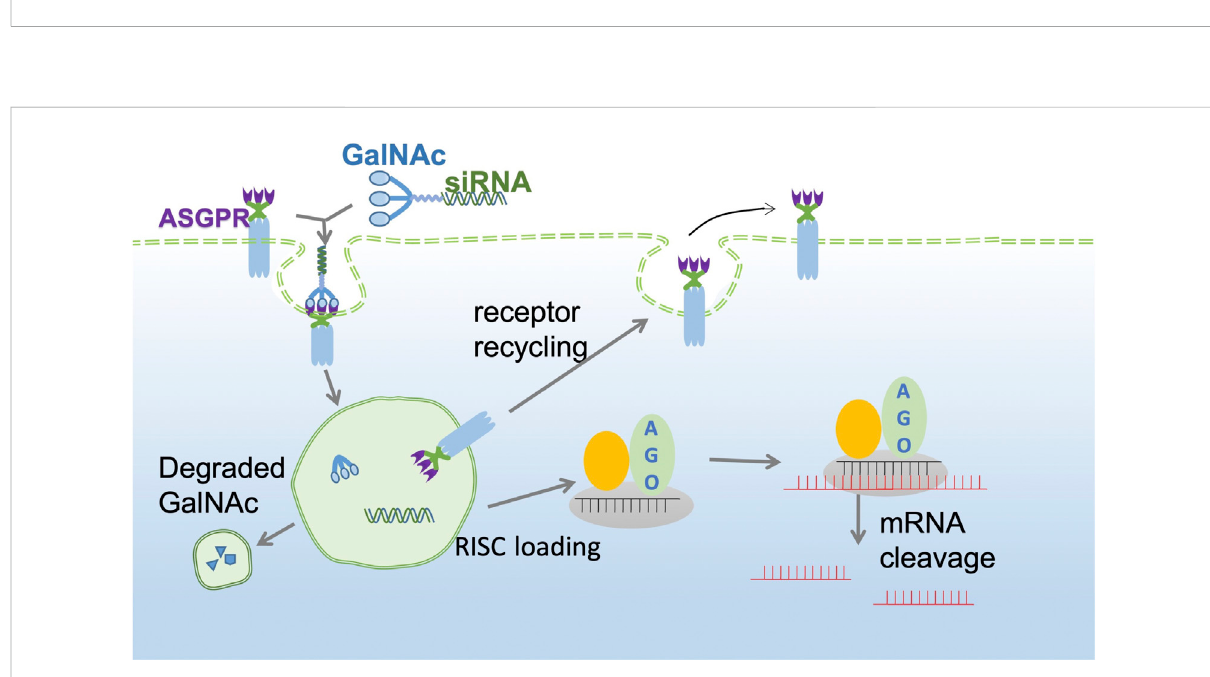
GalNAc-siRNA conjugate pathway. The GalNAc-siRNA conjugate binds to ASGPR receptors on the surface of hepatocytes and is then endocytosed into the cytoplasm to form endosomes. Due to the decrease in pH in endosomes, the siRNA GalNAc-ASGPR complex is decomposed, and less than 1% of free siRNA escapes to the cytoplasm to exert an RNAi effect. ASGPR will return to the surface of liver cells for recycling, while GalNAc will be degraded and excluded. The negative chain of siRNA, Ago2 protein and related enzymes together constitute RISC and guide RISC to bind to target mRNA to achieve target mRNA gene